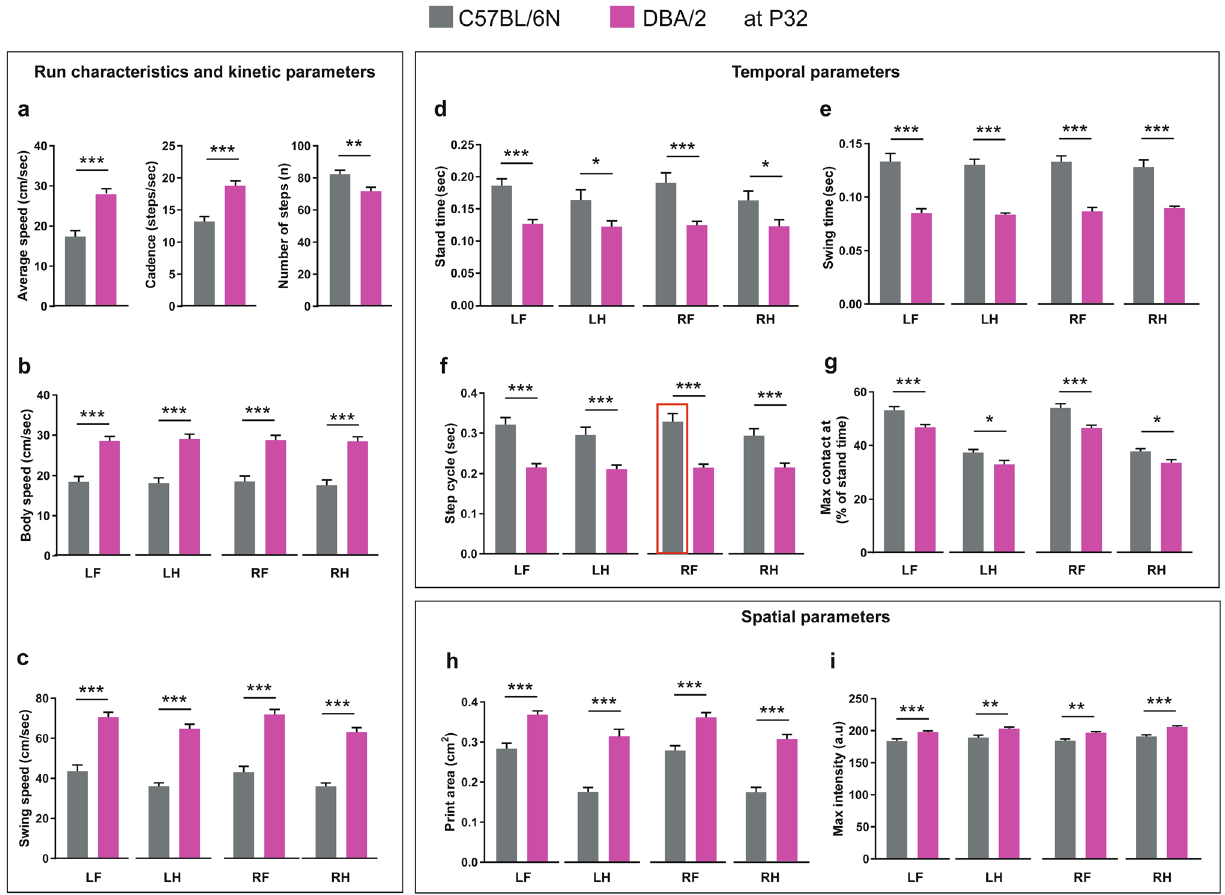
Figure 2. Comparison of run characteristics and kinetic, temporal and spatial parameters between C57BL/6N and DBA/2 mice at P32. ( a ) DBA/2 mice showed a significant increase in the average speed and cadence and a decreased number of steps compared to C57BL/6N mice. ( b , c ) DBA/2 mice showed an increase in body speed ( b ) and swing speed ( c ) in all paws compared to C57BL/6N mice ( d – g ) DBA/2 mice showed a significant decrease in stand time ( d ), swing time ( e ), step cycle ( f ) and maximum contact at (%) ( g ) of all paws compared to C57BL/6N mice. ( h , i ) DBA/2 mice showed an increase in print area ( h ) and maximum intensity ( i ) of all paws compared to C57BL/6N mice. Two-way ANOVA followed by Bonferroni post hoc test, * p ≤ 0.05, ** p ≤ 0.01, *** p ≤ 0.001. A red rectangle indicates a significant difference between sexes within a strain (see Supplementary Table S1). Error bars indicate the standard error of the mean (SEM). RF right front, LF left front, RH right hind, LH left used mainly the alternate pattern (Ab) during the run with significantly reduced Aa and Cb patterns compared to C57BL/6N mice (Fig. 5g). Comparing male and female mice within the aforementioned strains revealed no difference in the run char- acteristic or kinetic parameters. On the other hand, for temporal parameters, the stand time and step cycle of mainly front paws of males C57BL/6N mice was more than of females (Stand time: LF: p = 0.004, RF: p = 0.005; Step cycle: LF: p = 0.007, LH: p = 0.03, RF: p = 0.008) (Supplementary Table S1). For spatial parameters, the right paws of DBA/2 male mice showed increased print areas compared to females (RF: p = 0.028, RH: p = 0.003), with only the RF paw of male DBA/2 mice showing an increase in the maximum intensity ( p = 0.005) (Supplementary Table S1). For interlimb coordination parameters, the base of support of hind paws in male C57BL6N mice was more than females ( p < 0.0001). The support percentage showed sex-biased results with females C57BL/6N mice showing more support on two paws (diagonal) than males ( p = 0.049). For the regularity index, female C57BL/6N mice showed an increased regularity index than males ( p = 0.008). For DBA/2 mice, only the phase dispersion of LF with RF as the anchor paw showed a sex difference with females showing a higher percentage than males ( p = 0.022) (Supplementary Table S1). Comparison of running characteristics and spatial, temporal and interlimb coordination param- eters in C57BL/6N mice between P32 and P42. The comparison between P32 and P42 C57BL/6N mice revealed no difference in the run characteristics or kinetic parameters (Supplementary Figure S1a–c), and for the temporal parameters, no difference in stand time, swing time or step cycle was found between the two ages (Supplementary Figure S1d–f). On the other hand, only the LH paw of P42 C57BL/6N mice showed a